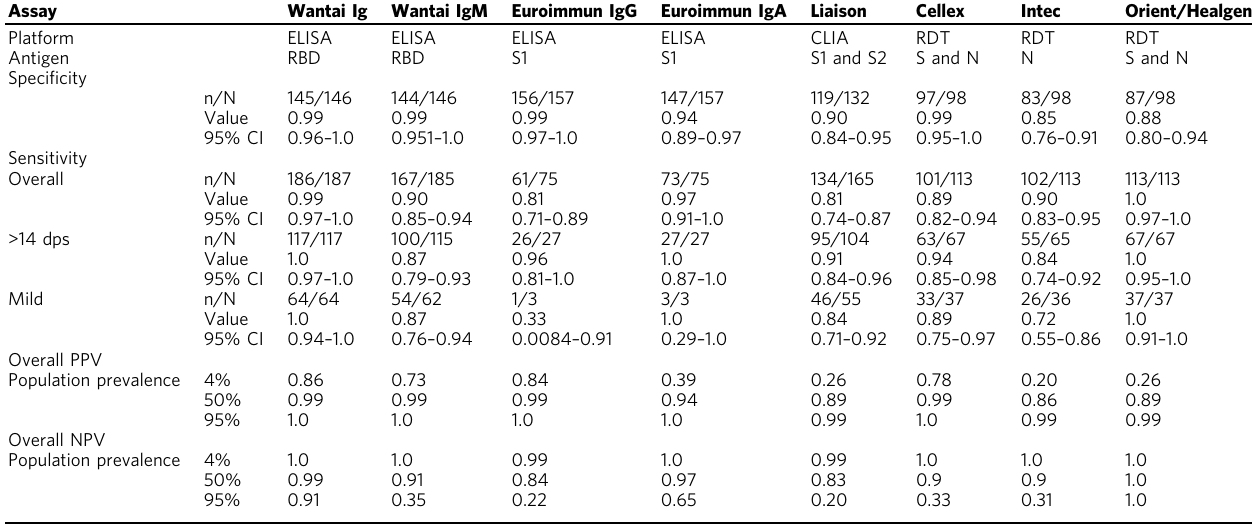
Sensitivity of the assays was determined by comparing the outcome to virus neutralization (PRNT> 20). Patients were considered mild if they have not been admitted to a hospital. The PPV was calculated for 3 scenarios: 4 % seroprevalence in a general population. 50% seroprevalence in a high risk sub-population and 90% seroprevalence in hospitalized patients suspect for COVID-19. Ig: immunoglobulin, ELISA: enzyme linked immunosorbent assay, CLIA: chemiluminescence immune assay, RDT: rapid diagnostic test, n:number of positives, N: total number tested, CI: con fi dence interval, dps: days post onset of symptoms, PPV: positive predictive value, NPV: negative predictive value, PRNT: plaque reduction neutralization